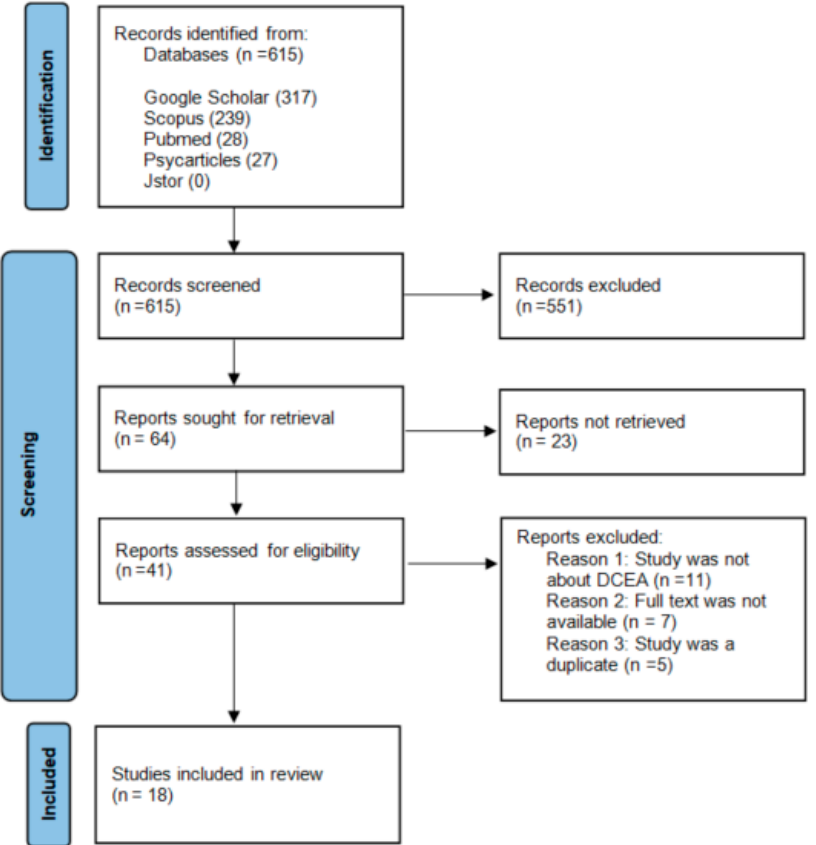
Figure 1. PRISMA flowchart; search and selection process.